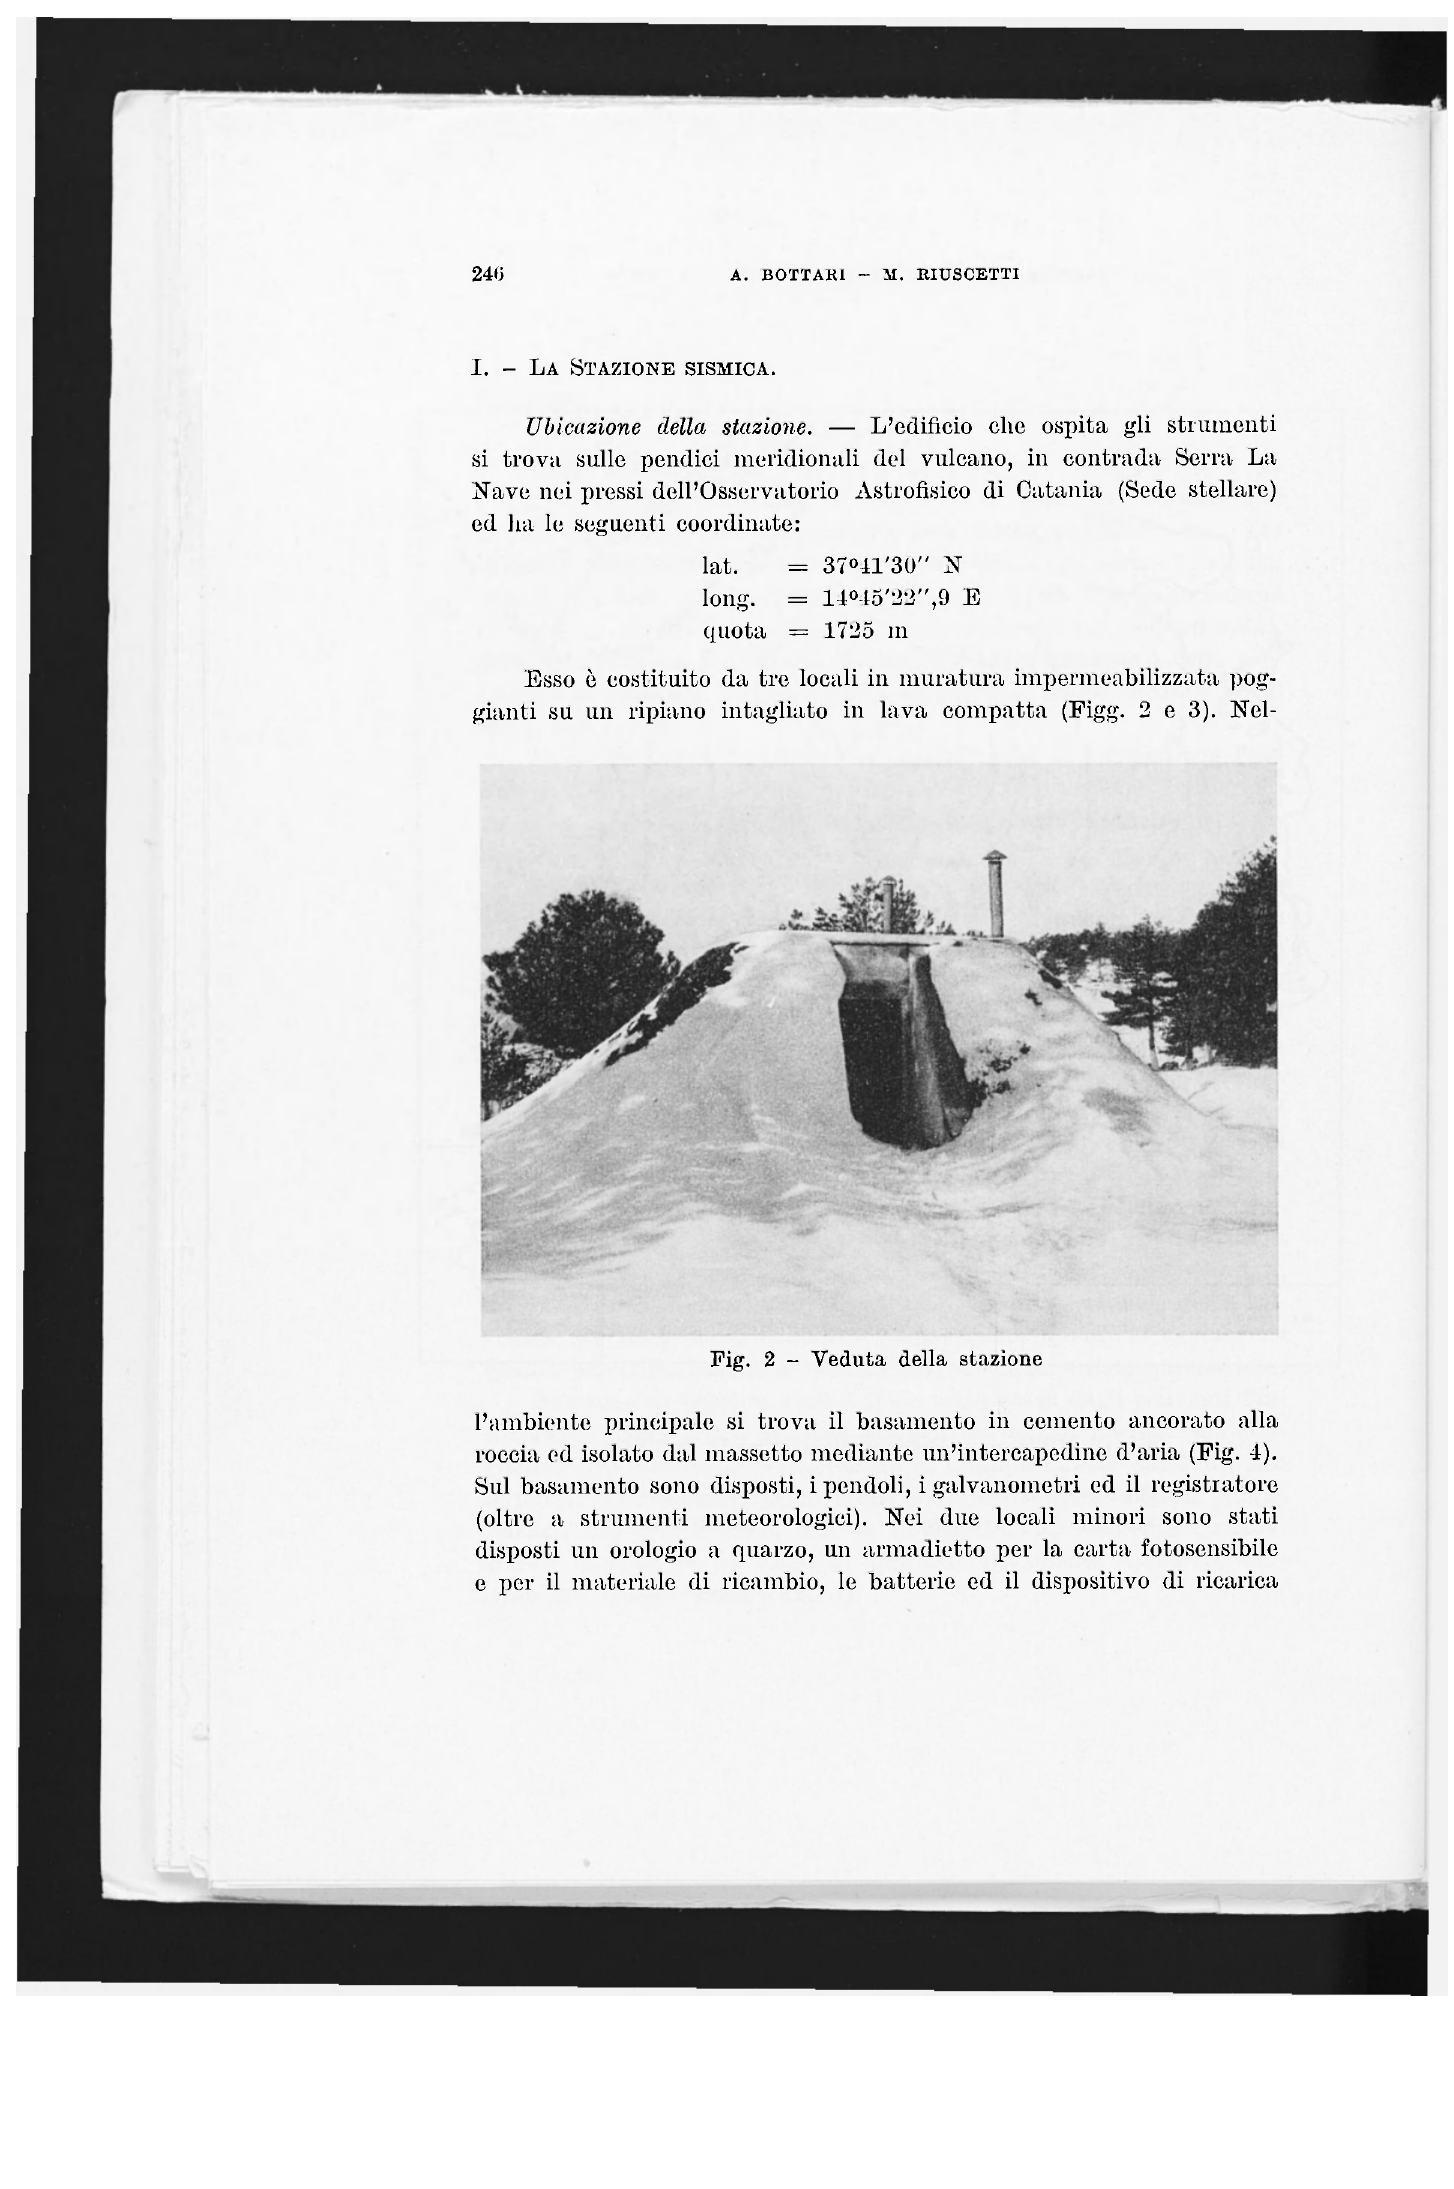
Fig. 2 - Veduta della